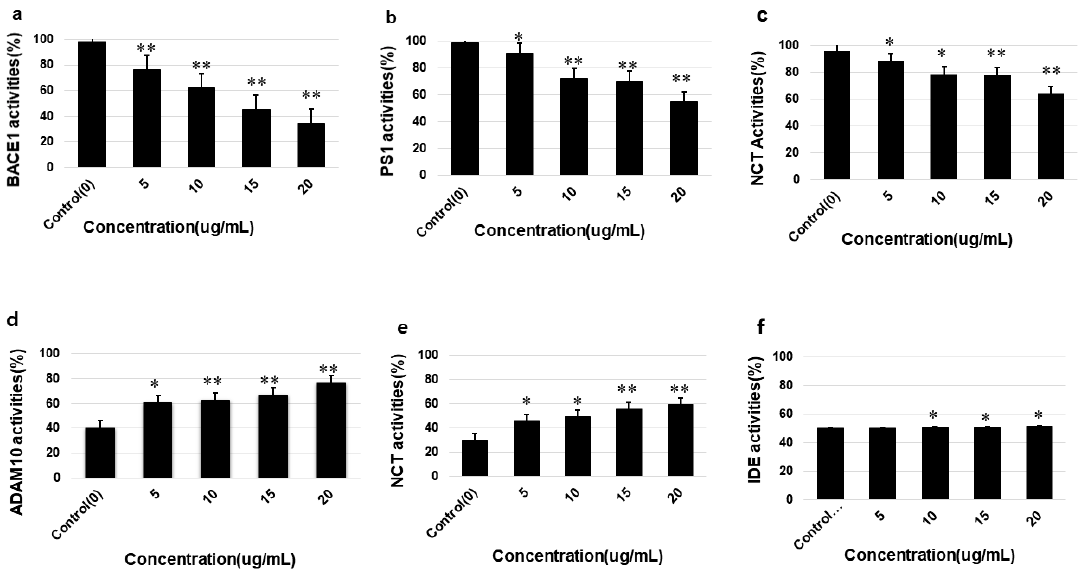
Figure 5. E ff ects of theasaponin E1 on the activities of APP cleaving proteases and A β degrading enzymes in vitro determined by fluorometric assays. Percent activity was measured for control and treatment groups for each enzyme. ( a ) E ff ects of theasaponin E1 on β -secretase (BACE1) activities. ( b ) E ff ects of theasaponin E1 on γ -secretase (PS1) activities. ( c ) E ff ects of theasaponin E1 on γ -secretase (NCT). ( d ) E ff ects of Theasaponin E1 on α -secretase (ADAM10) activities. ( e ) E ff ects of theasaponin E1 on neprilysin activities. ( f ) E ff ects of theasaponin E1 on insulin degrading enzyme (IDE) activities. Data are expressed as mean ± SEM. Data were analysed with one-way ANOVA ( n = 3). (* p < 0.05; ** p < 0.01).